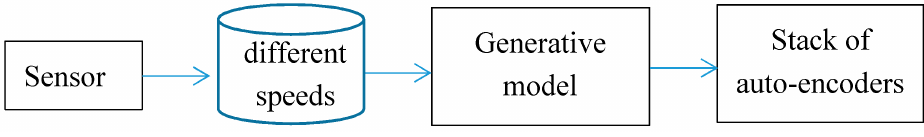
Figure 1. Training phase.